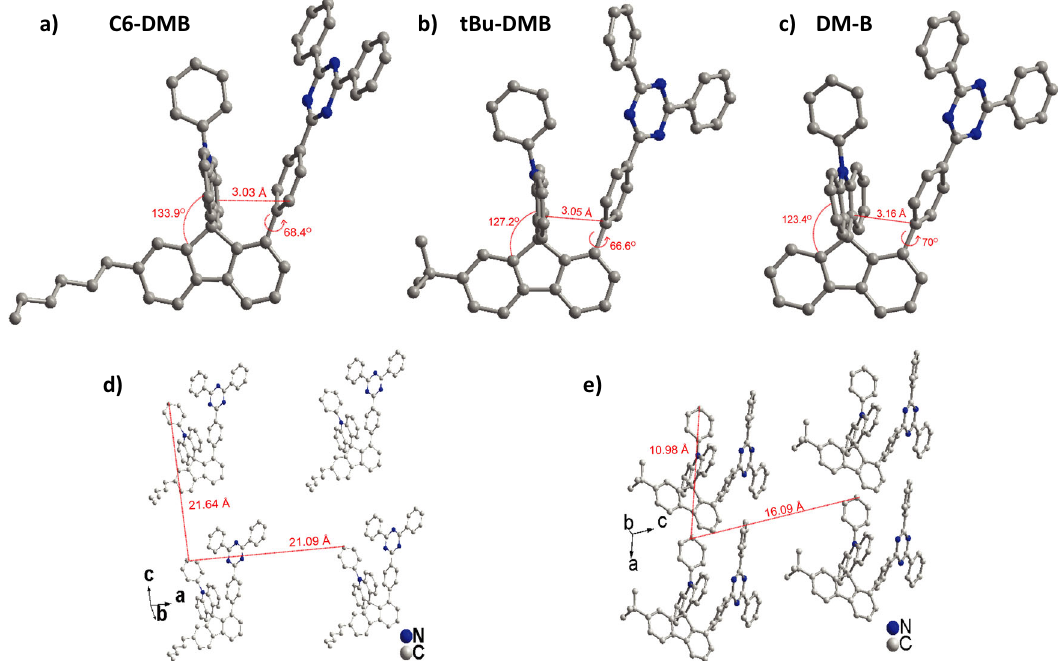
Fig. 3 Single-crystal X-ray structures. Crystal structures of ( a ) C6-DMB , ( b ) tBu-DMB , ( c ) DM-B , and molecular packing arrangements of ( d ) C6-DMB and ( e ) tBu-DMB . Hydrogen atoms have been omitted for the sake of clarity. Crystallographic data have been deposited with the Cambridge Crystallographic Data Centers supplementary publication no. CCDC-2153900 ( C6-DMB ), CCDC- 2153902 ( tBu-DMB ). These data can be obtained free of charge from The Cambridge Crystallographic Data Centre: